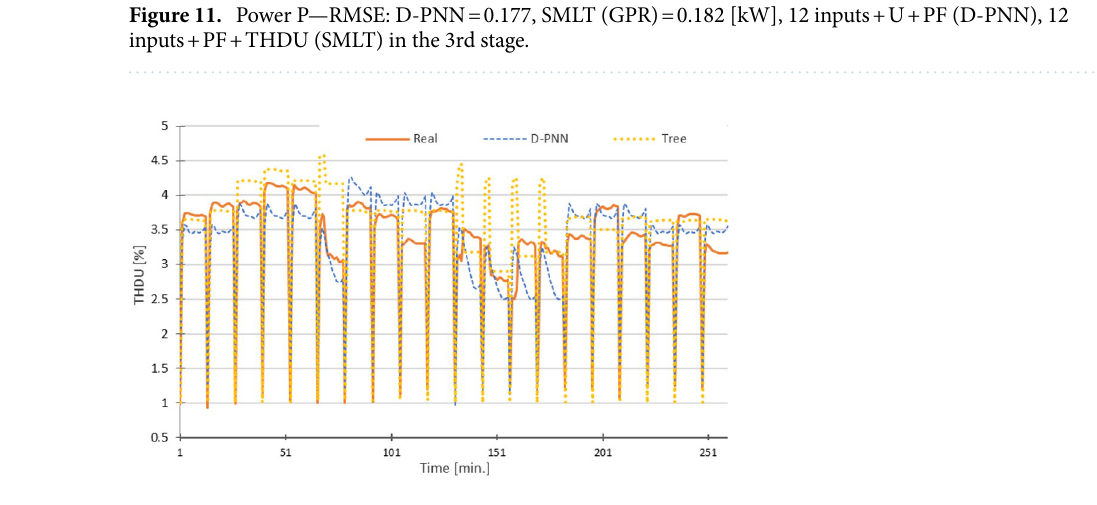
Figure 12. THDU—RMSE: D-PNN = 0.429, SMLT (Tree) = 0.443 [%], 12 inputs + U (both D-PNN and SMLT) in the 2nd